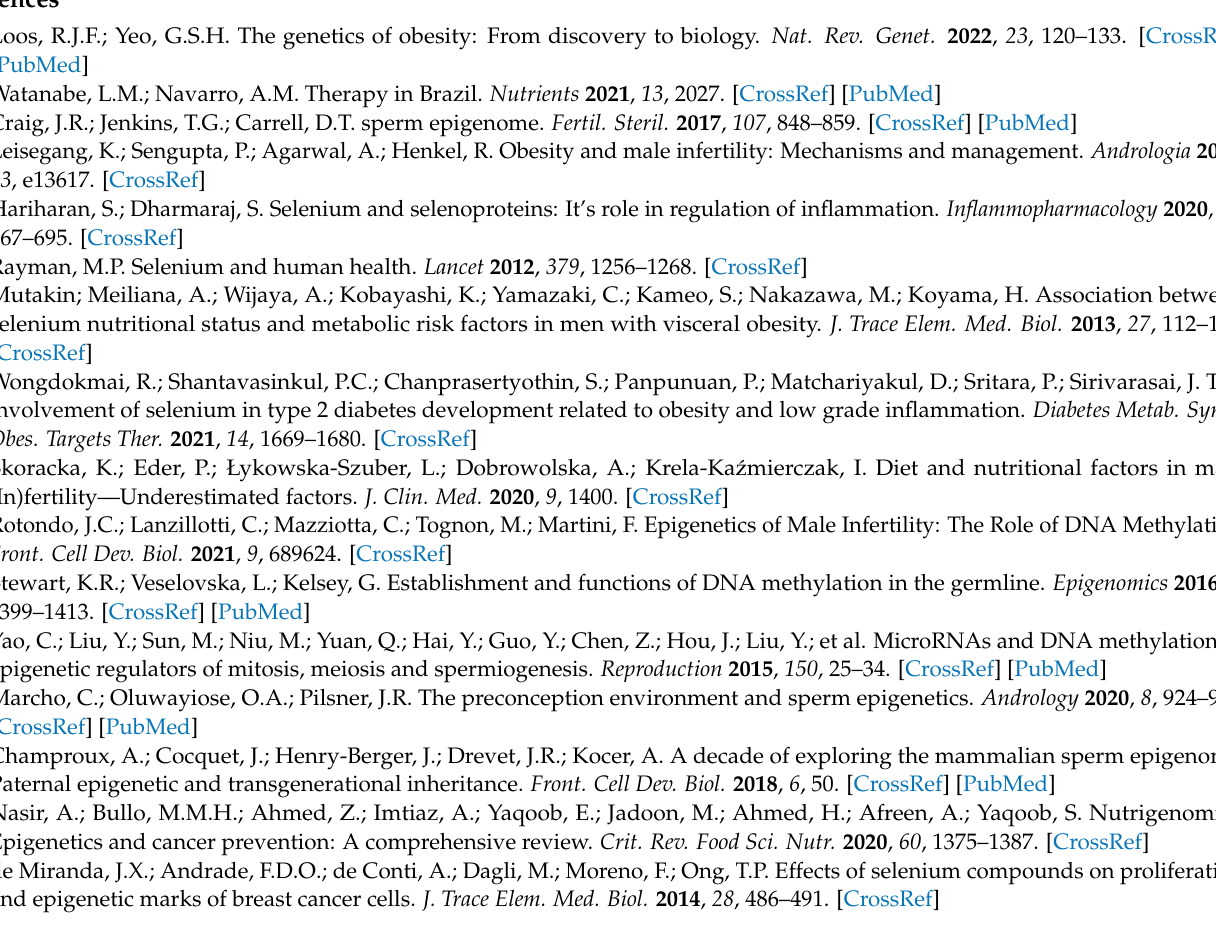
fat diets composition, Table S2: Primer sequences used in real-time PCR for mRNA expression analysis, Table S3: Taqman assays used for the analysis of miRNA expression by qPCR (Thermo Fisher Scientific, Waltham, MA,